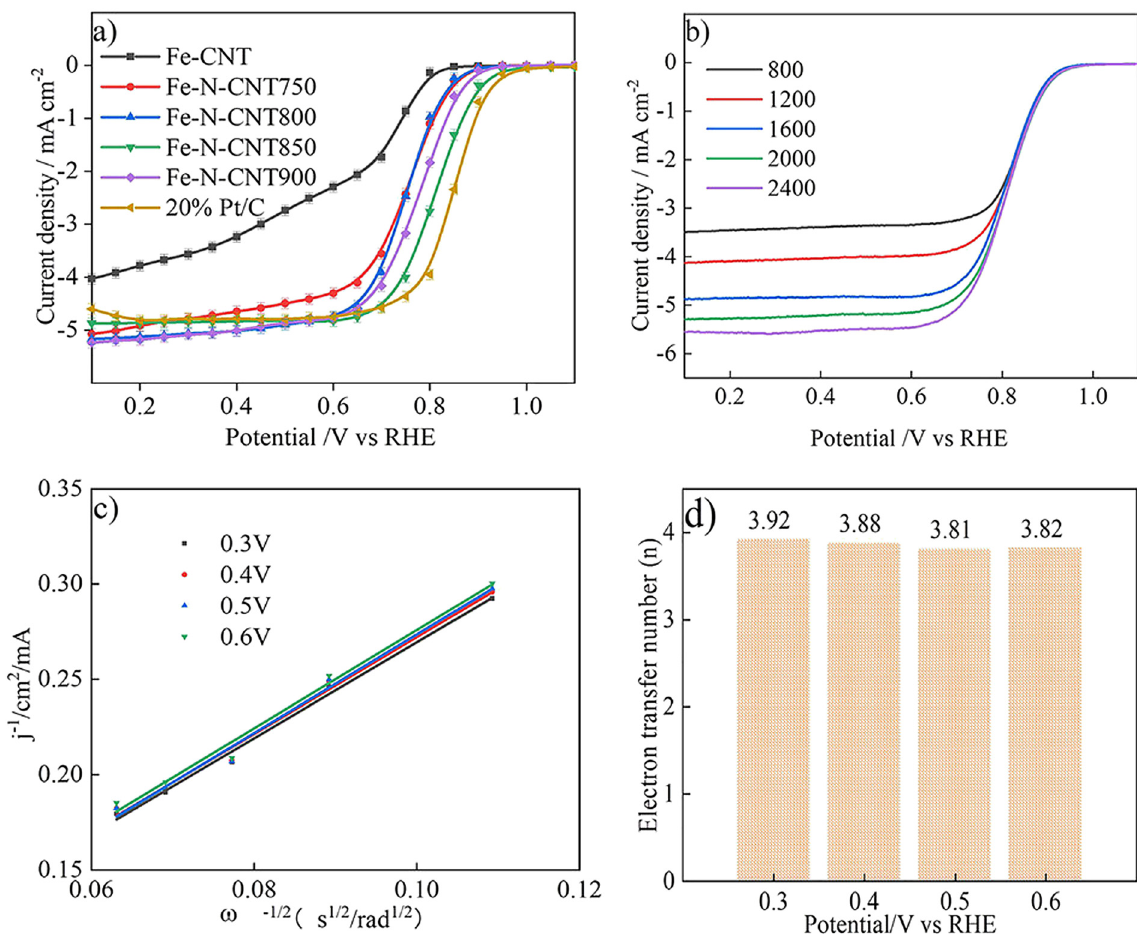
Figure 43: ( a ) LSV curves of O 2 - saturated solutions for all catalysts at a scan rate of 5 mV s − 1 and a rotation speed of 1,600 rpm. ( b ) Fe – NCNT850 LSV curves at various rotation speeds. ( c ) Fe – NCNT850 K – L plot at various potentials. ( d ) Fe – NCNT850 catalyst electron transfer number ( n ) . Copied with permission from ref. [ 454 ] ; John Wiley and Sons, 2020.